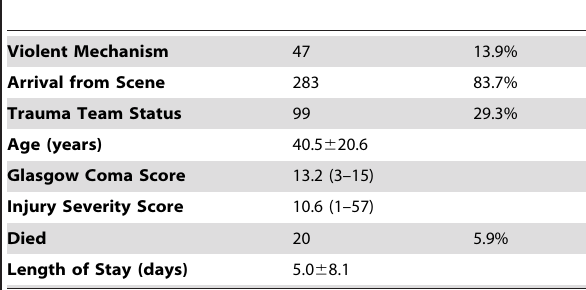
Table 2. SEHC and Langdorf Trauma Activation Patients alcohol and illicit drug minimum and tested rates.